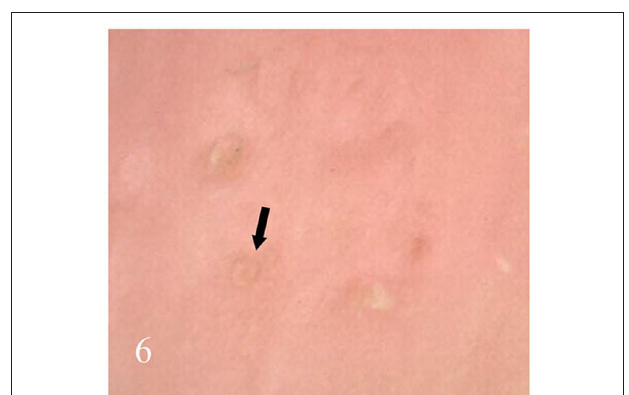
FIGURE 2 | Thin arrows indicate longitudinal striae; thick arrows indicate longitudinal nail fissures.